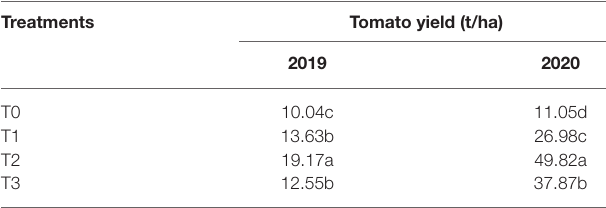
TABLE 4 | Tomato yield with organic and organo-mineral fertilizer application. Treatments Tomato yield